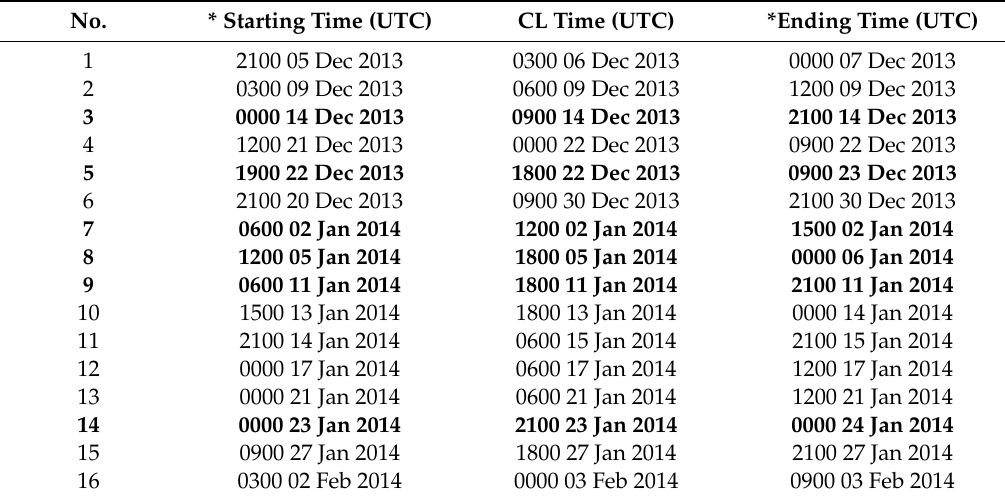
Table 1. Cold / warm fronts passage.